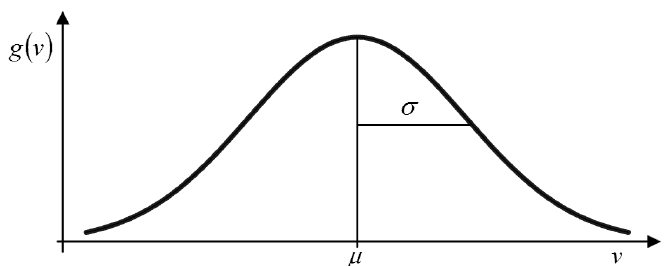
Figure 1. Graphical representation of local Gaussian